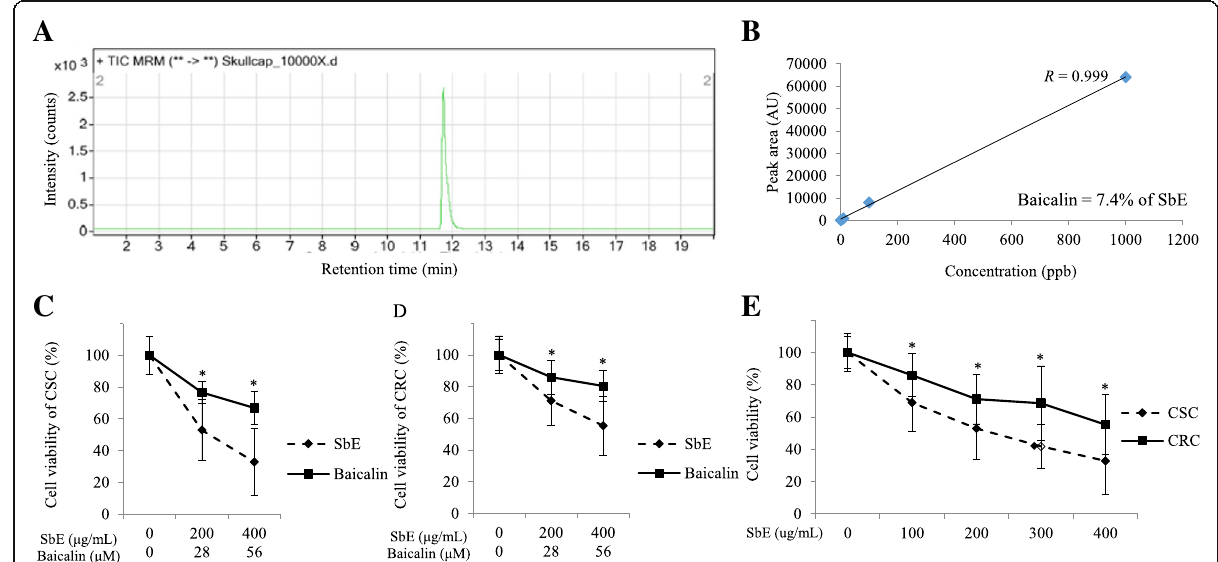
Fig. 3 Quantitative analysis of baicalin in SbE and effects of SbE and baicalin on the cell viability in CSC and CRC. a LC-MS analysis of baicalin in SbE. b Baicalin peak area in LC-MS as a function of baicalin concentration (correlation coefficient, R = 0.999) and the percent content of baicalin in SbE. Cells were exposed 200 ~ 400 μ g/mL of SbE or 28 ~ 56 μ M of baicalin for 24 h. Cell viability according to SbE or baicalin treatment in ( c ) CSC and ( d ) CRC was determined by MTT assay. Cells were exposed 100 ~ 400 μ g/mL of SbE for 24 h. e Cell viability according to various concentrations of SbE treatment in CSC and CRC was determined by MTT assay. Each value is the mean ± SD. p < 0.05 was taken to define statistical significance. Two tailed